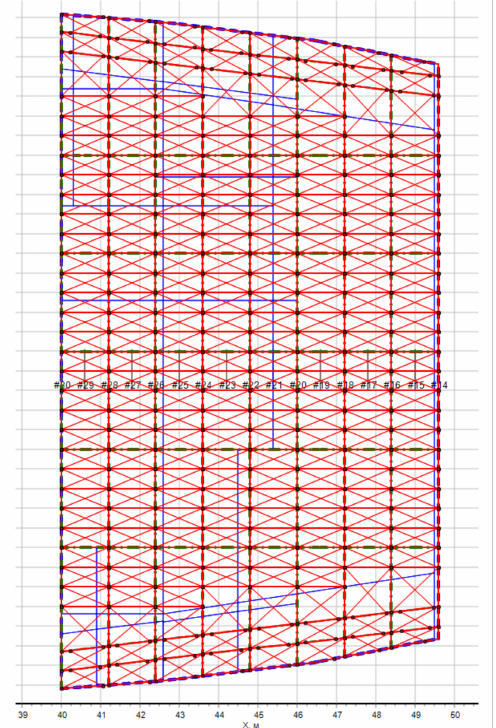
Figure 13. The result of EPPs identification for the upper deck in the fore part of a ship (242 EPPs, 1.15 s required). In this Figure the blue lines are the borders of the plates, red crosshairs—detected